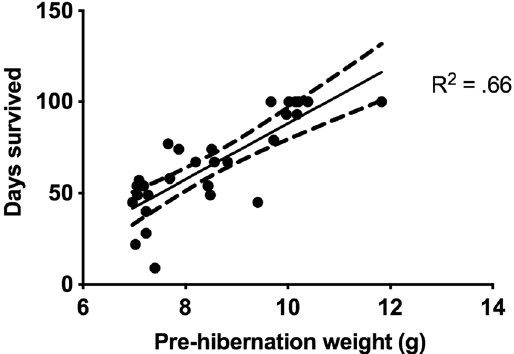
Figure 1. Myotis lucifugus survival was correlated to pre-hibernation weight. The number of days bats survived after challenge with Pseudogymnoascus destructans is plotted against pre-hibernation weight, with Pearson correlation test line and confidence intervals.